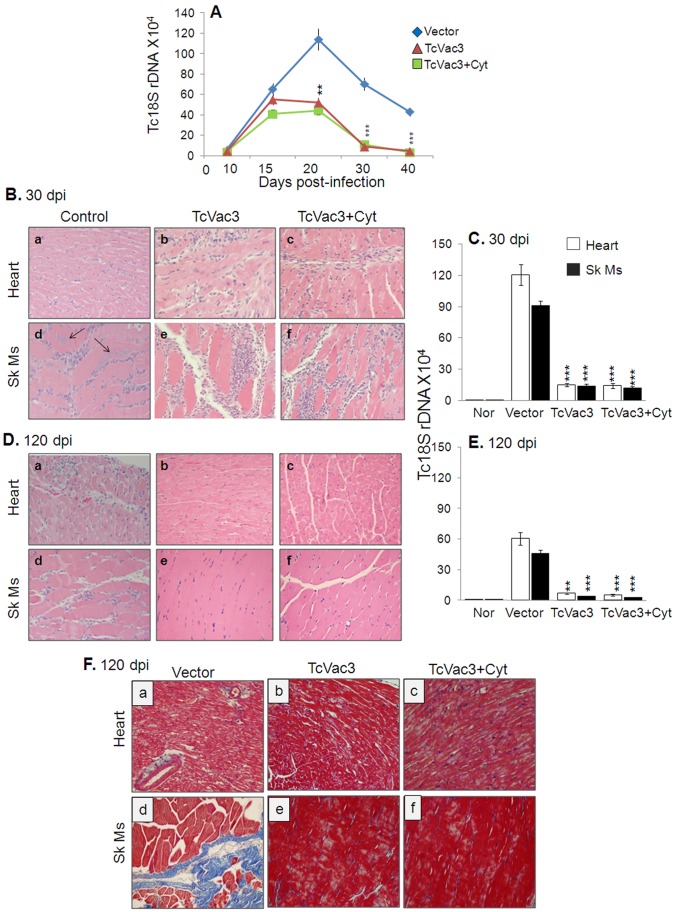
TcVac3 efficacy in controlling the inflammatory infiltrate, tissue pathology and parasite burden in mice.Mice were vaccinated and infected with T. cruzi. Peripheral blood collected at days 10–40 post-infection (A), and tissues harvested at day 30 (B&C) and 120 (D–F) post-infection were utilized. (A) Blood parasite level determined by real time PCR amplification of Tc18SrDNA sequence, normalized to GAPDH. (B&D) The representative images of H&E staining (blue: nuclear, pink: muscle/cytoplasm/keratin) of heart tissue and skeletal muscle sections (magnification: 20X) are shown (arrows indicate parasite nests). (C&E) Tissue parasite burden was determined by real time PCR amplification of Tc18SrDNA sequence, normalized to GAPDH. (F) Masson’s Trichrome staining (magnification 20X). The intense blue color shows collagen deposition (fibrotic area).